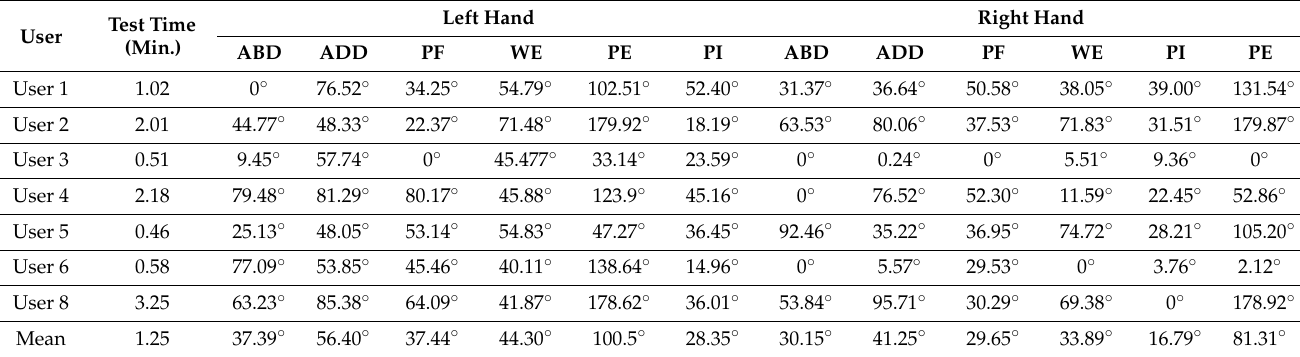
Table 1. Example of the data recorded in the Fruit Bowl scenario.